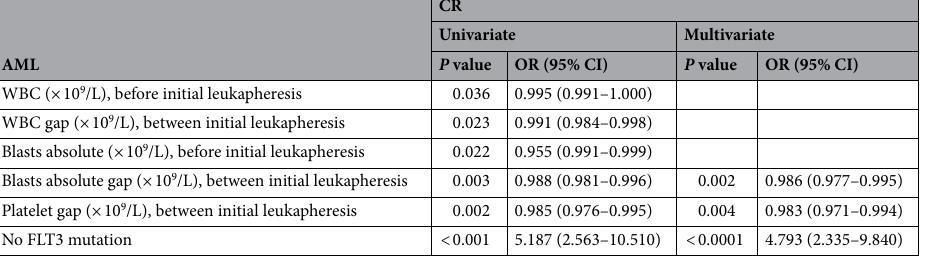
Table 2. Prediction for complete remission (CR) using univariate and multivariate logistic regression in acute myeloid leukaemia (AML) group. OR odds ratio, CI confidential